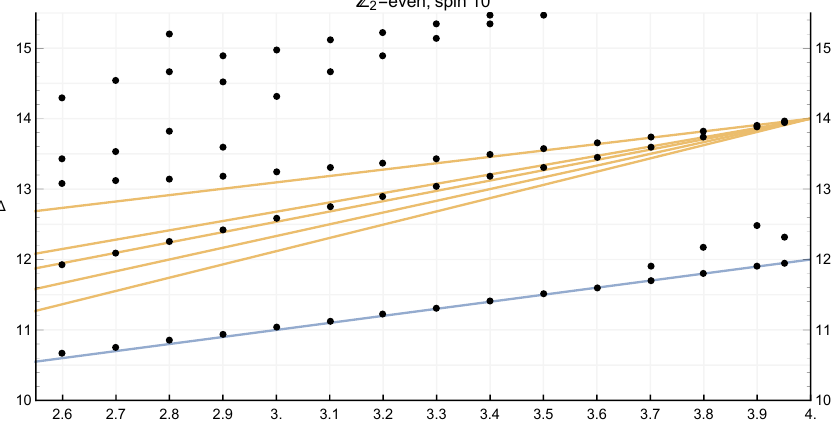
Figure 9 . Z 2 -even operators of spin 10.